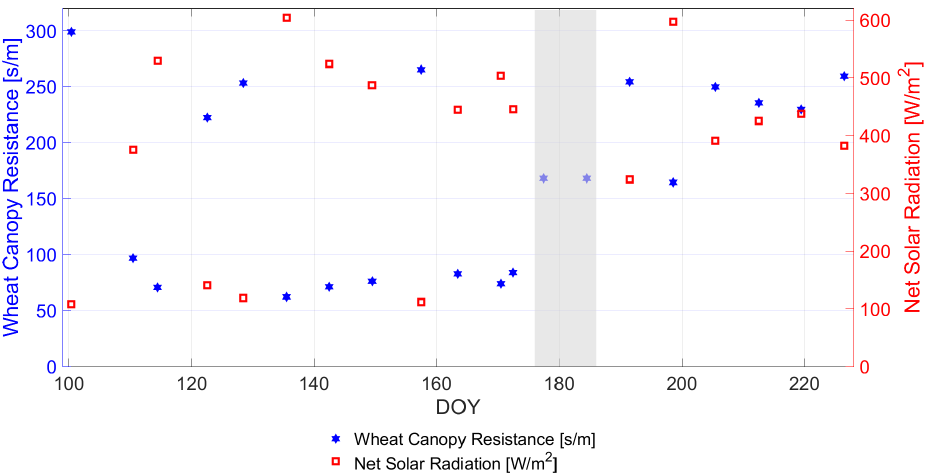
Figure 7. Comparison of the in situ-measured net solar radiation [Wm − 2 ] and the calculated stomata resistance R ST [sm − 1 ] of the winter wheat canopy from the model of Choudhury and Idso (1985a) under incorporation of VWP observations (cf. Fig. 1) along days of year (DOY). The gray area indicates two dates where no net solar radiation measurement was available and the resistance values for the canopy are set to fixed values of 168[sm − 1